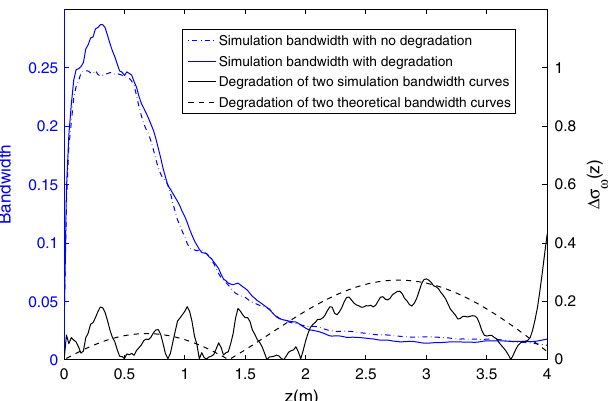
FIG. 2. (Color) Simulations of bandwidth curves and bandwidth degradation. The theoretical degradation curve is copied from Fig. 1. The beam energy modulation for the degraded bandwidth curve is the same as in Fig. 1. The simulation parameters are listed in Table I.